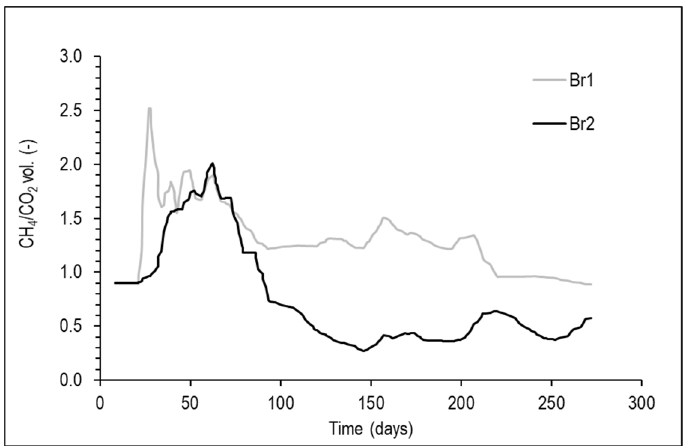
Figure 4. CH 4 /CO 2 ratio behaviour.